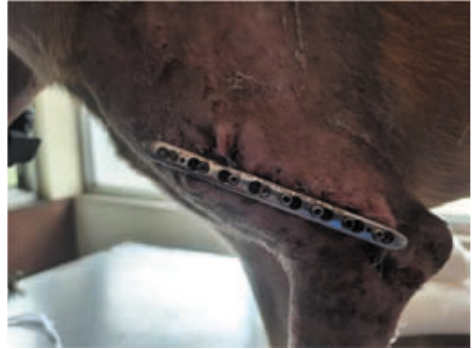
Fig. 1. Implant in position after